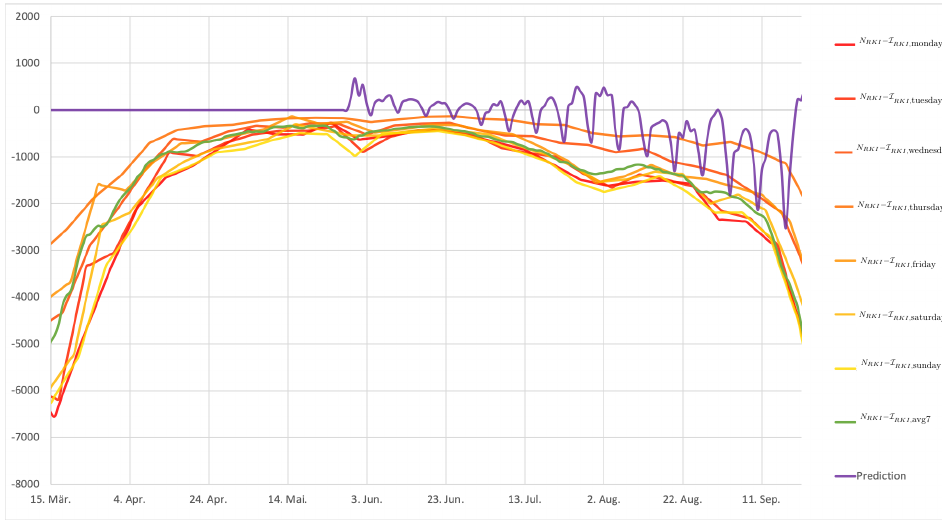
Figure 11. Error curves for the respective day of interpolation and their average marked in green; the calculated prediction is marked in